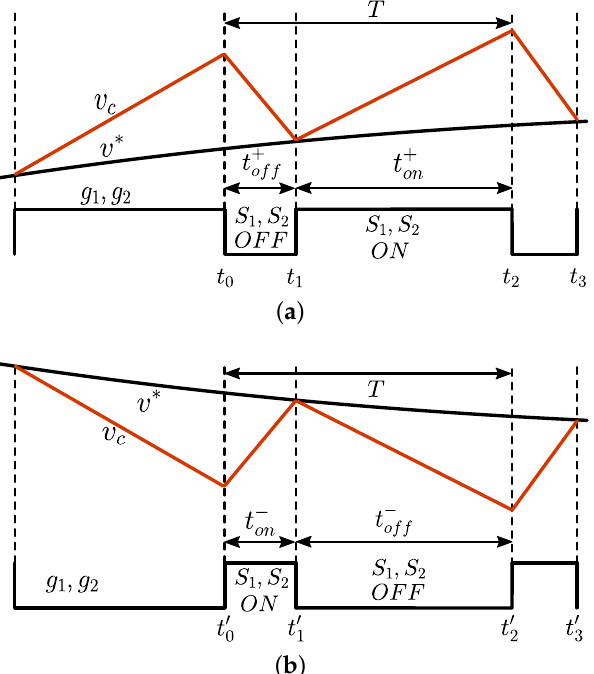
Figure 4. Sketch of voltage waveform within two switching cycles during ( a ) positive half cycle and ( b ) negative half